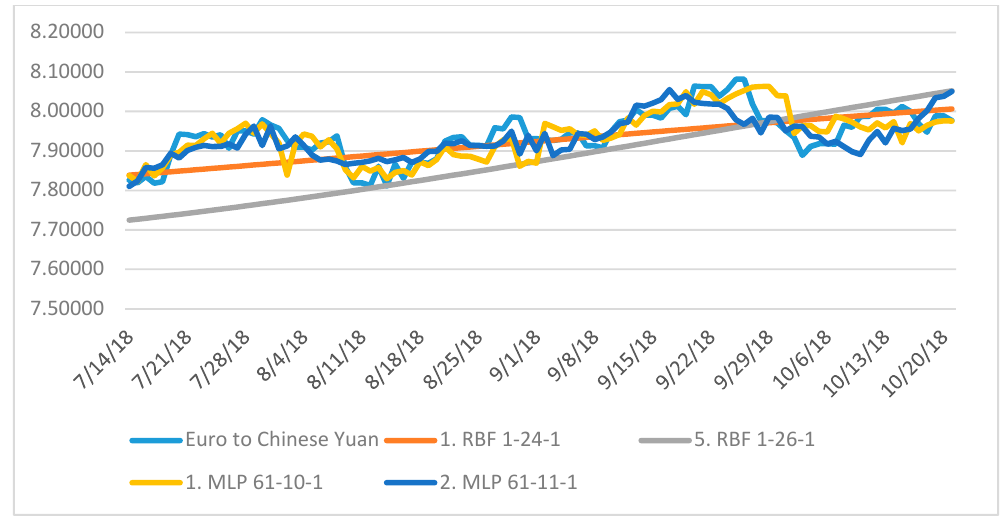
Figure 10. Line graph—comparison of retained neural networks in equalizing time series of development of Euro to Yuan exchange rate between 14th July and 21st October 2018. (Source: Own processing.)